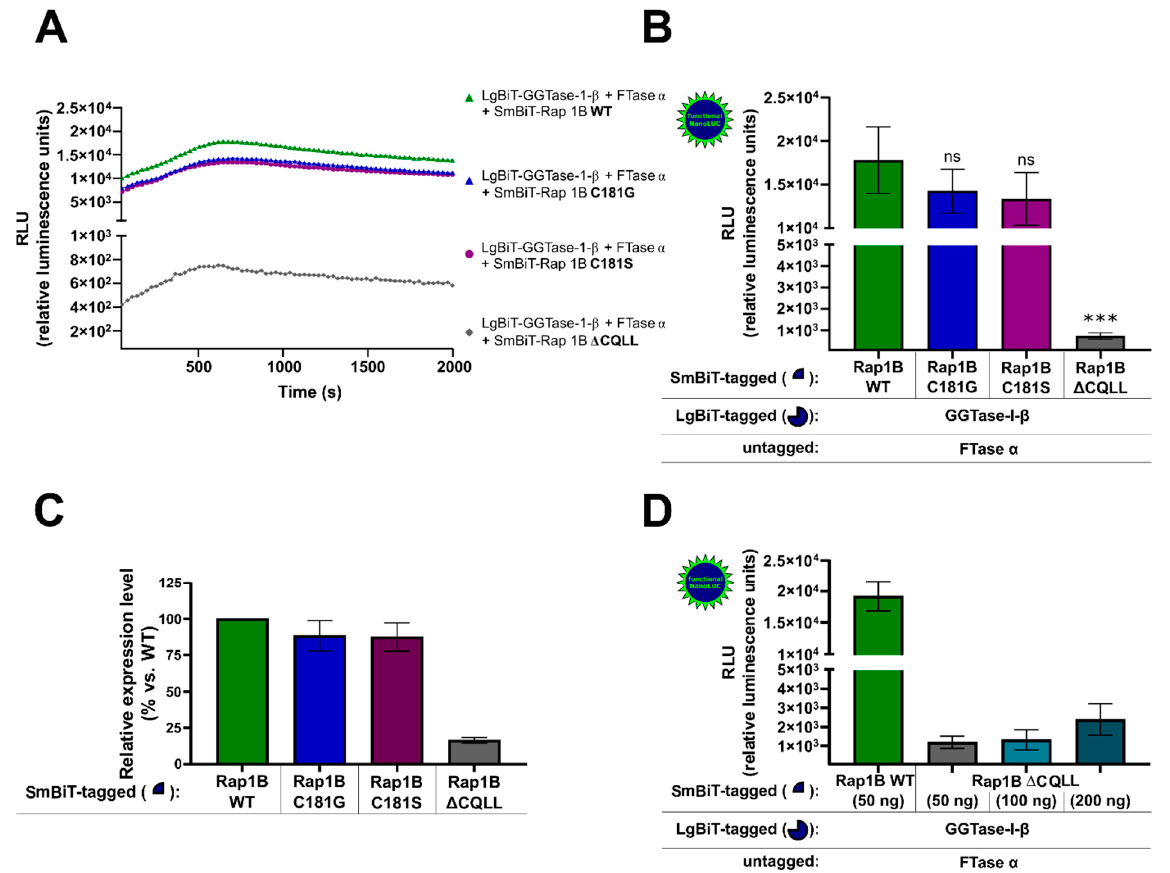
Figure 3. NanoBiT complementation assay to measure the interaction of GGTase-I and the Ras-related protein Rap1B mutants C181G, C181S, ∆ CQLL. HEK293 cells stably expressing the A 2B AR were transiently co-transfected as described in Figure 1. From the Rap1B mutants C181G, C181S, 50 ng DNA/well and from Δ CQLL 50–200 ng DNA/well were used. ( A ) Real-time kinetic measurement of heteromer formation using the NanoBiT assay. Twenty-four hours after transfection, the NanoGlo live-cell substrate was added, and the association was immediately monitored at 25 °C over a time period of 42 min with a luminescence reading taken every 30 s. ( B ) After a time period of ~ 700 s, the maxima of complex formation were reached, and the relative luminescence units (RLU) were plotted. No significant differences between LgBiT-GGTase-I- β /FTase α /SmBiT-Rap1B WT and the LgBiT-GGTase-I- β /FTase α /SmBiT-Rap1B mutants C181G, C181S were observed (ns, not significant). Significant differences were observed between LgBiT-GGTase-I- β /FTase α /SmBiT-Rap1BWT and the LgBiT-GGTase-I- β /FTase α /SmBiT-Rap1B mutant that was missing the CAAX motif ( Δ CQLL) (*** p < 0.001). ( C ) Densitometric quantification of SmBiT-Rap1B WT, SmBiT-Rap1B C181G, SmBiT-Rap1B C181S, and SmBiT-Rap1B Δ CQLL expression in HEK293 cells. Protein levels are represented as ratio values quantified from protein bands of each sample versus GAPDH compared to SmBiT-Rap1B WT expression (set as 100% expression). Three independent Western blots were performed. ( D ) Increasing plasmid amounts of SmBiT-Rap1B Δ CQLL (50–200 ng DNA/well) were transiently co-transfected in HEK293 cells stably expressing the A 2B AR. After the maxima of complex formation were reached, the relative luminescence units (RLU) were plotted.